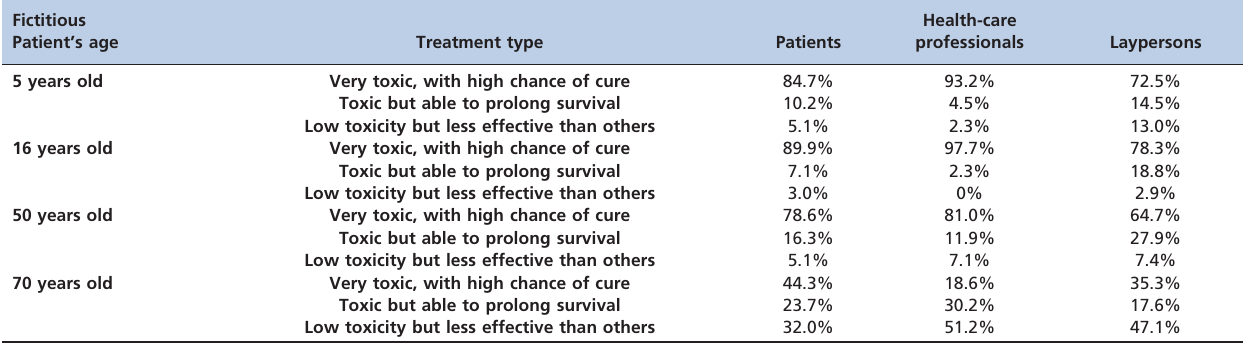
Table 4 - Treatment aggressiveness for fictitious cancer patients in four age groups, according to participant group (see Appendix for complete definitions of treatment types).